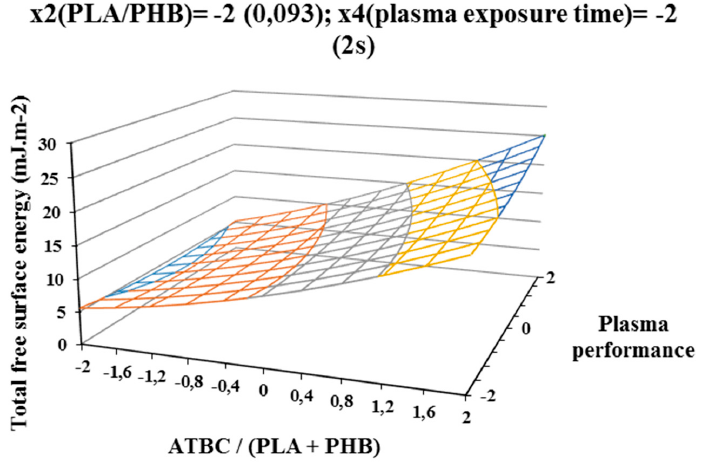
Figure 5. Response surface of difference of the polar component of free surface energy measured immediately after plasma surface treatment in dependence of factors x1 (ATBC / (PLA + PHB)) and x3 (plasma power) at constant factor x2 (PHB / PLA) = − 2 and x4 (exposure time) plasma) = − 2.